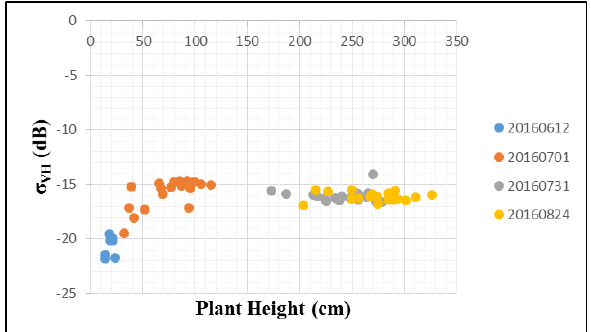
Figure 3. Correlation between σ VH and Plant Height.